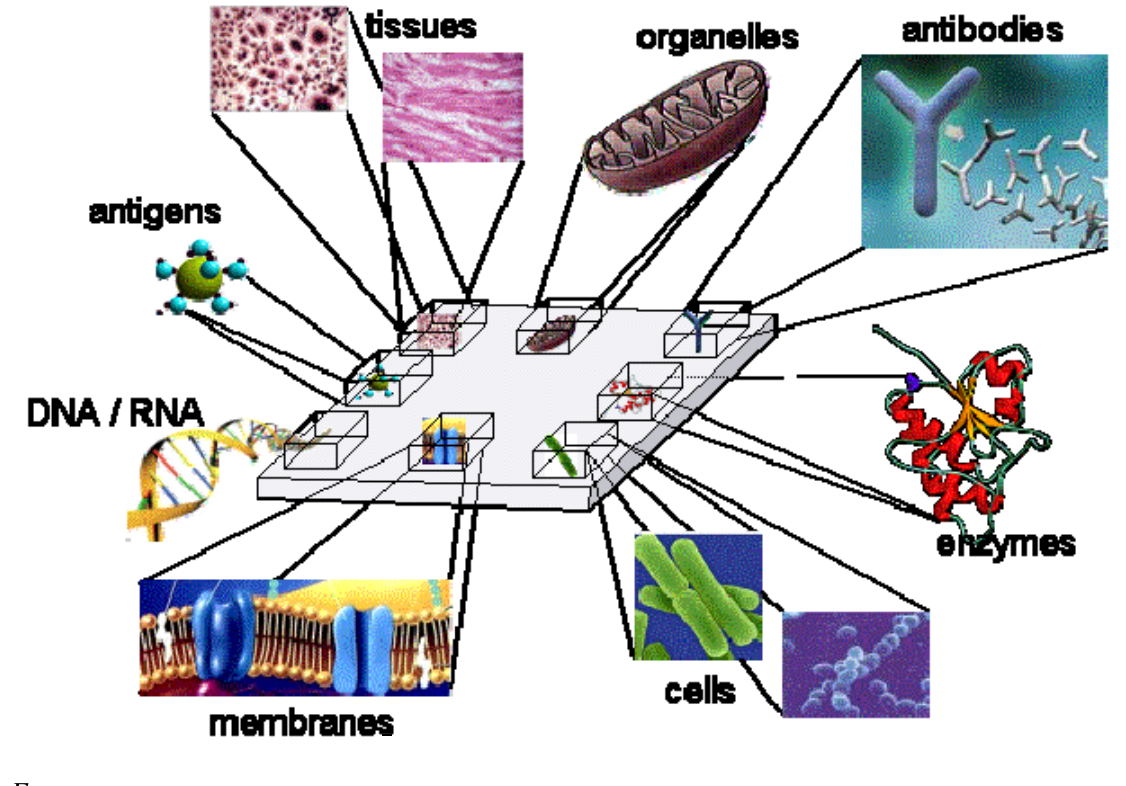
Figure 4. Bioreceptors eligible for attachment to the electrode